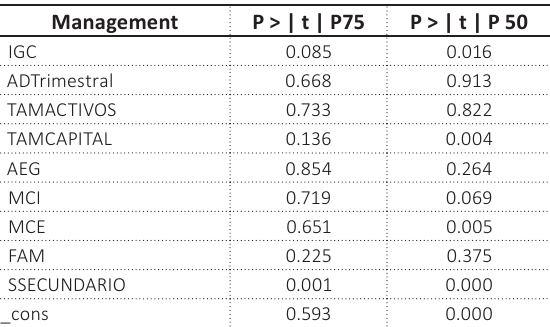
Table 7. Comparison of management estimates